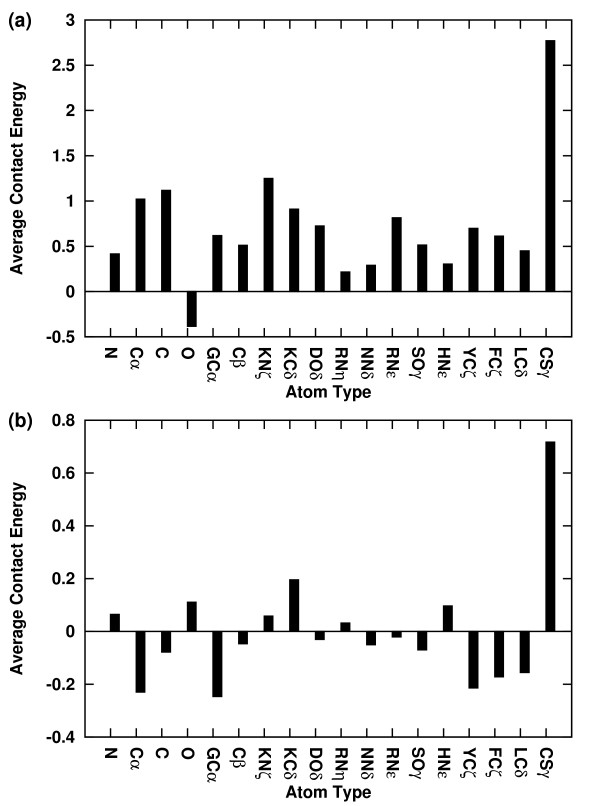
Average inter-atomic contact energy per atom type for the first (Panel a) and second (Panel b) step. Averaging was done over all atom types.